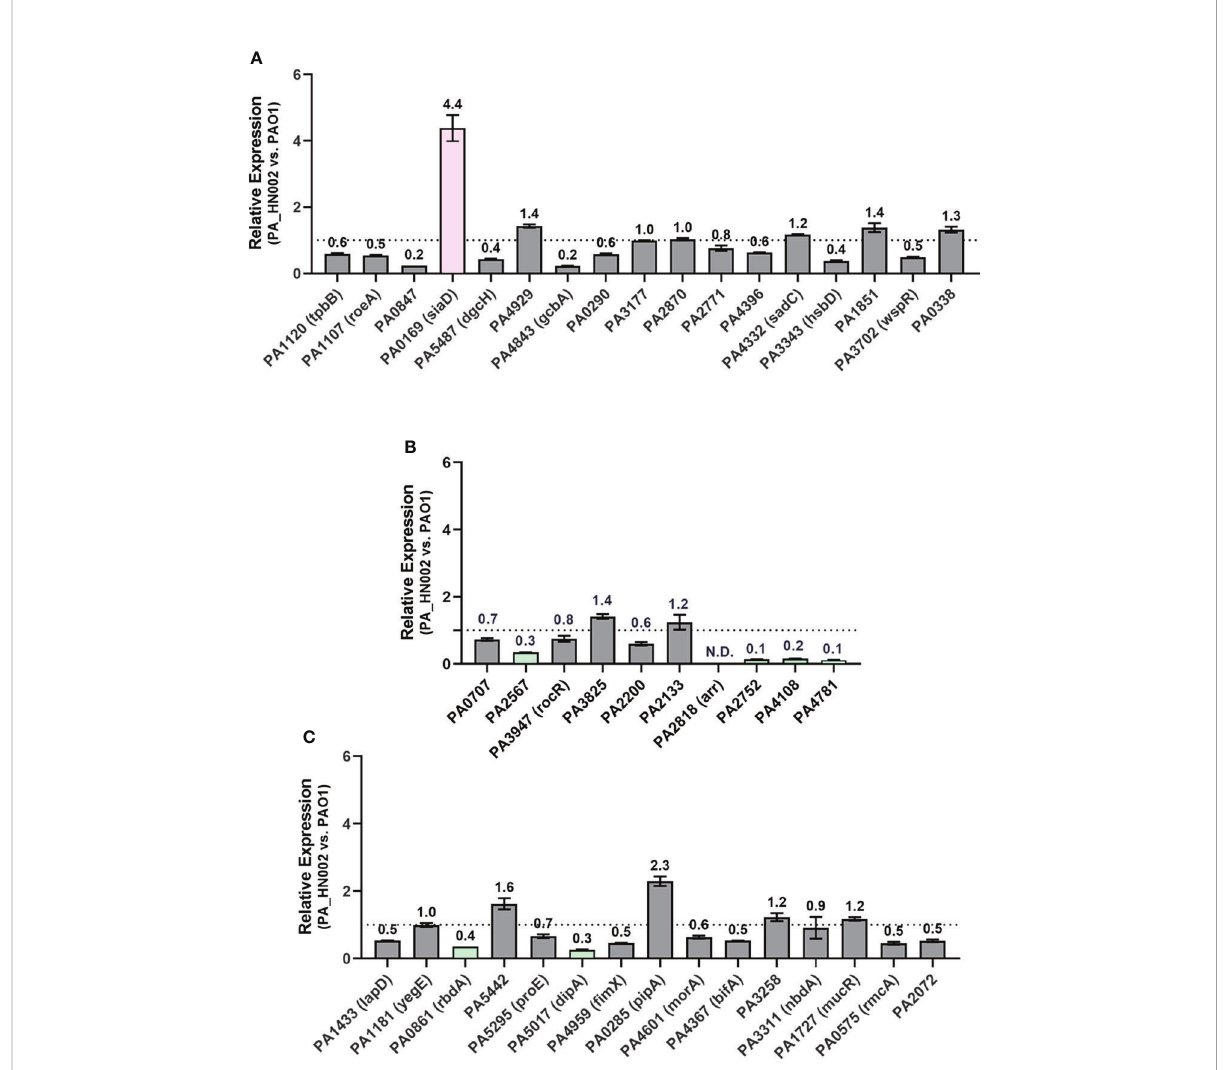
FIGURE 7 Relative expression of the genes encoding c-di-GMP metabolizing enzymes in PA_HN002 and PAO1. (A) Enzymes only contain the GGDEF domain. (B) Enzymes contain either EAL or HY-GYP domain. (C) Enzymes contain both the GGDEF and EAL domains. The DGC-encoding gene siaD in PA_HN002 was highlighted in pink while the genes encoding PDE enzymes with more than 2-fold changes such as PA2567, PA4108, PA4781, PA0861 ( rbdA ), PA5017 ( dipA ) and PA0285 were highlighted in green. N.D., Not